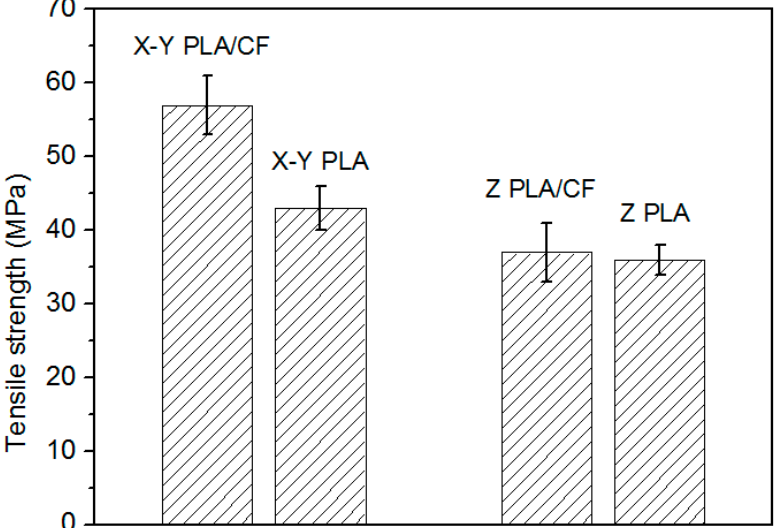
Figure 3. Tensile strength of the polylactic acid–carbon fiber (PLA–CF) specimens. 137